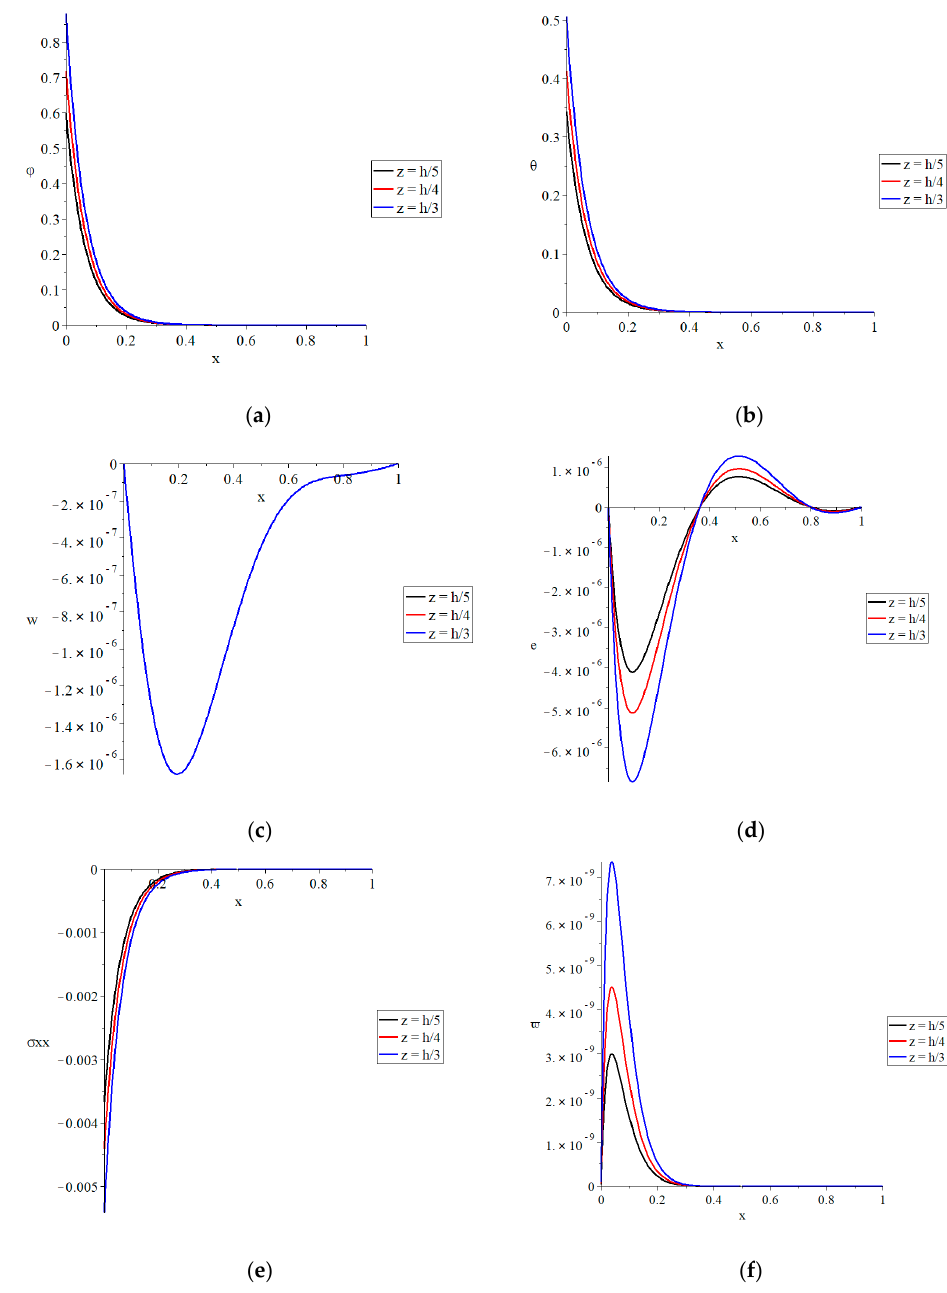
Figure 5. The distributions with variance thickness z when β = 1.0, t 0 = 1.0, a = 0.5. ( a ) The distribution of conductive temperature, ( b ) the distribution of dynamical temperature, ( c ) the distribution of lateral deflection, ( d ) the distribution of strain, ( e ) the distribution of stress, ( f ) the distribution of strain energy density function.